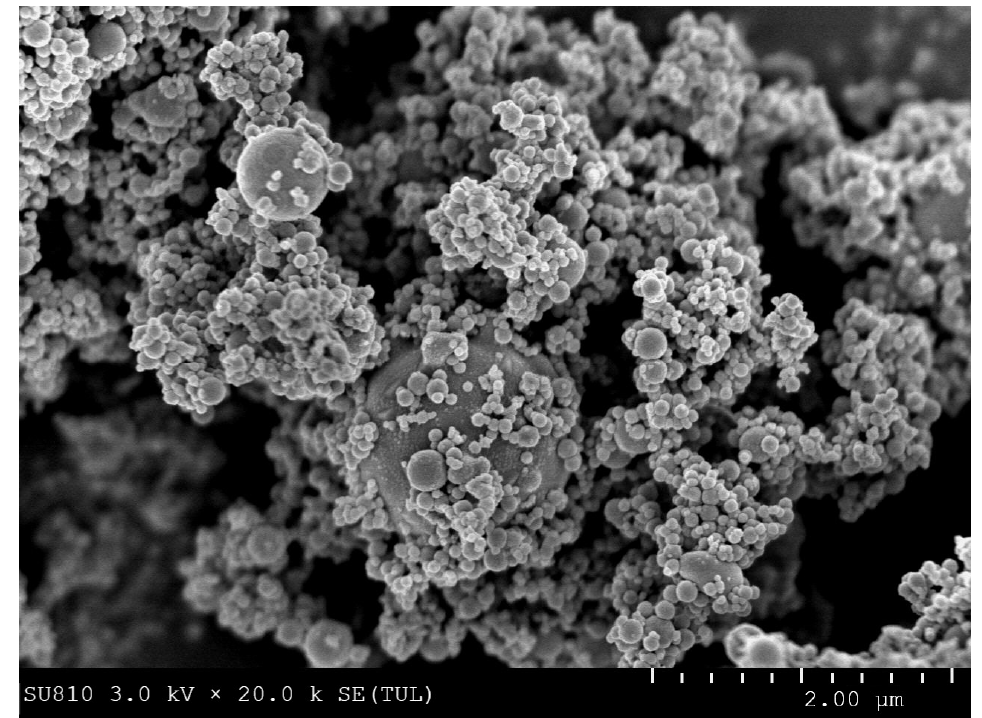
Figure 2. Scanning electron micrographs of Beauveria brongniartii Fe 0 NPs.